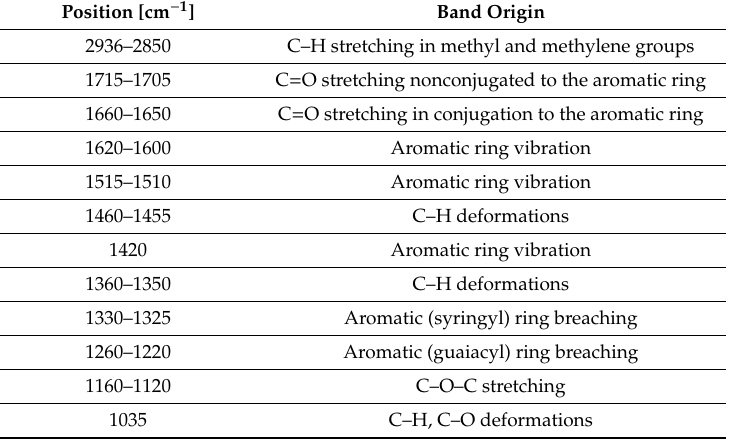
Figure 1. Fourier transform-infrared (FT-IR) of lignin from ( a ) Miscanthus ×giganteus , ( b ) M. sacchariflorus , ( c ) M. sinensis , ( d ) S. bicolor , and ( e ) S. saccharatum (bright green line — during vegetation before the AD; dark green line — during vegetation after the AD; yellow line — after vegetation before the AD; brown line — after vegetation after the AD). Table 2. FT-IR bands characteristic for lignin obtained from DV and AV materials, before and after the AD process [42,43].